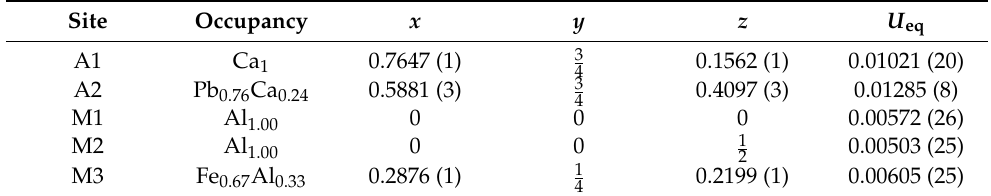
Table 8. Atom coordinates and isotropic displacement parameters (in Å 2 ) for hancockite. Refined